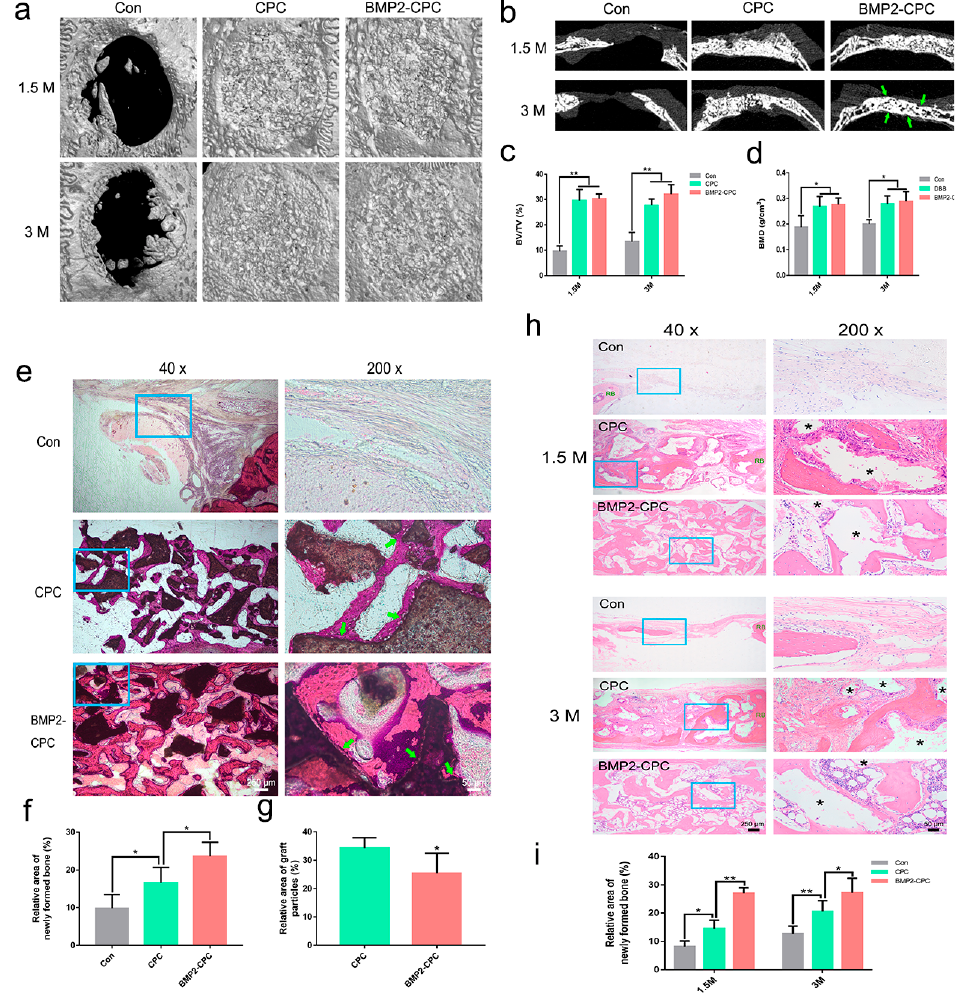
Figure 5. Micro-CT analysis and HE staining results. ( a ) Three-dimensional reconstruction images of the defects in each group; ( b ) transverse micro-CT images of the defects in each group (green arrows mark the two-layer cortical bone-like structure); ( c ) quantitative analysis of the proportion of new bone volume in the defects in each group; ( d ) quantitative analysis of the bone mineral density in the defects in each group; ( e ) HE-stained images of the in vivo healing pattern in the defects in each group (undecalcified, 3 months after the surgery, green arrow marks the close contact between newly formed bone and graft particles); ( f ) quantification of the area of newly formed bone in the defects in each group; ( g ) quantification of the area of graft particles in the defects in each group; ( h ) HE-stained images of the in vivo healing pattern in the defects in each group (decalcified, * denotes residual graft particles); ( i ) quantification of the area of newly formed bone in the defects in each